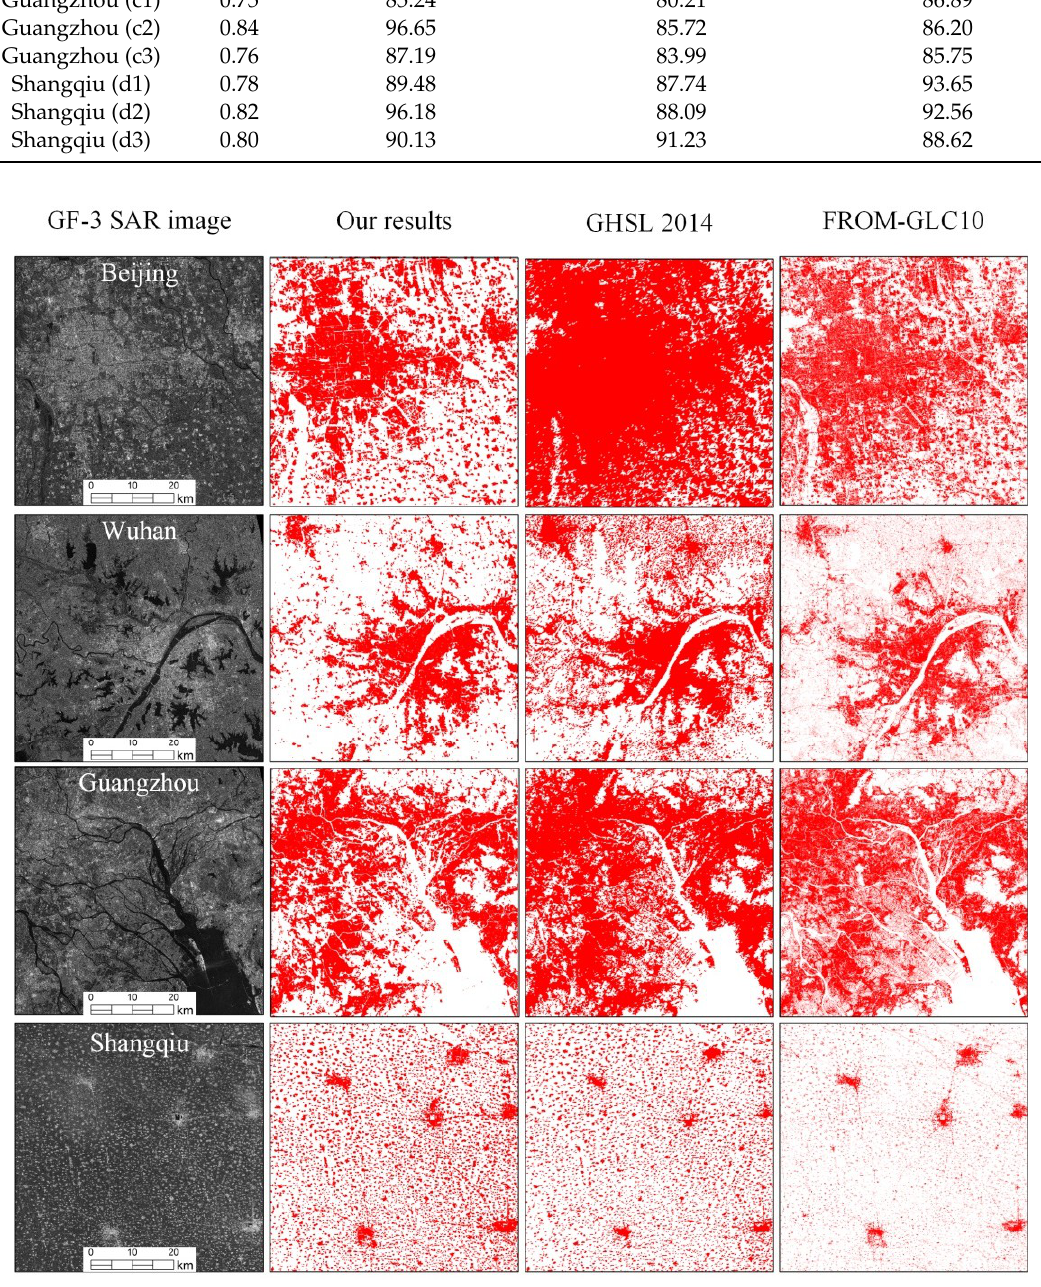
Figure 9. Comparison of our results and optical products. Table 5. Accuracy comparison of our results and optical products.